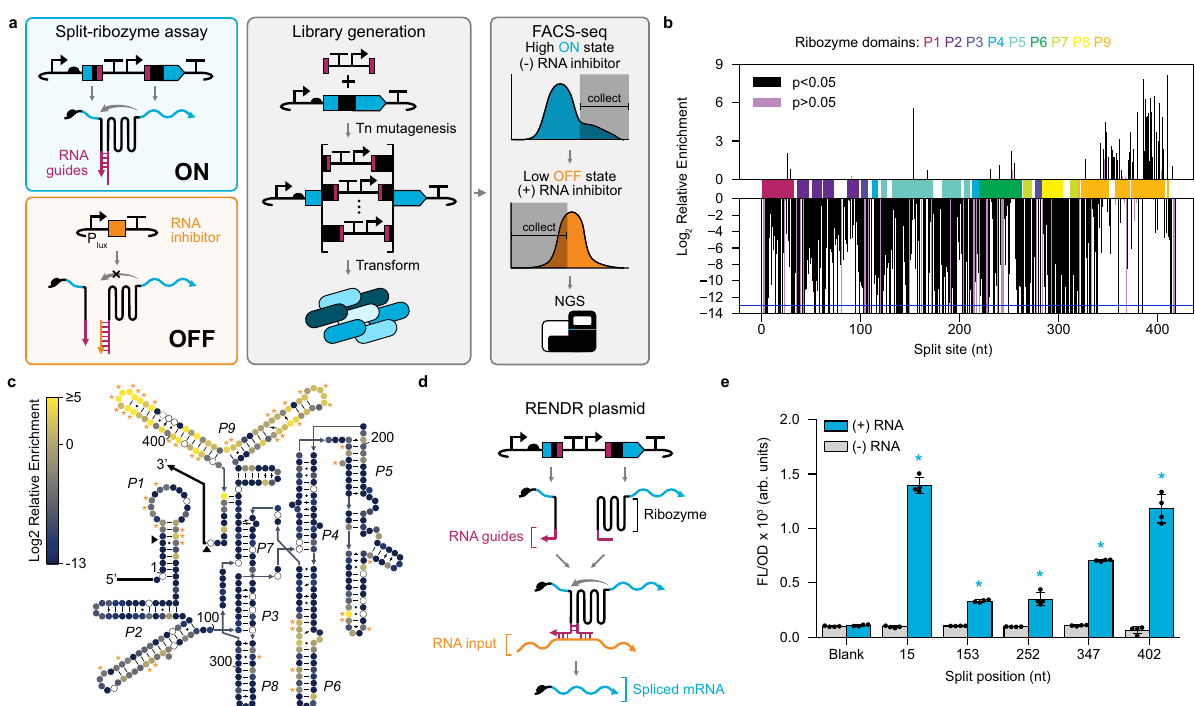
Fig. 2 | Screening of split ribozymes generates RENDR designs with a high dynamic range ofdetection. a High-throughput screening approach. Left, a split- ribozyme assayto determine splicing from eachsplitribozymein the absence(on) andpresence(off)ofadditionalstabilizingRNAinteractions.RNAguides(magenta) are used to facilitate interactions between ribozyme fragments, which are blocked with an RNA inhibitor (orange). Center, in vitro transposon mutagenesis is used to createalibraryofsplitsites.Right,FACS-seqisusedtoselectforsplitsiteswithhigh fl uorescence in the on state and low fl uorescence in the off state. b Relative enrichmentofribozymesplitsitesfollowingFACS-seq(P1 – P9domainsand p -values indicated).Atwo-tailedt-test(alpha=0.05)wasperformedonsortedandunsorted DNAfrequenciesateachsplitsiteandresulting p -valuesareprovidedintheSource Data fi le.Databelowthebluelinerepresentsiteslostduringselection. c Secondary structureofthe ribozyme containing enrichment data for each splitsite (circle fi ll) and split sites identi fi ed through colony screening (orange asterisks). Un fi lled